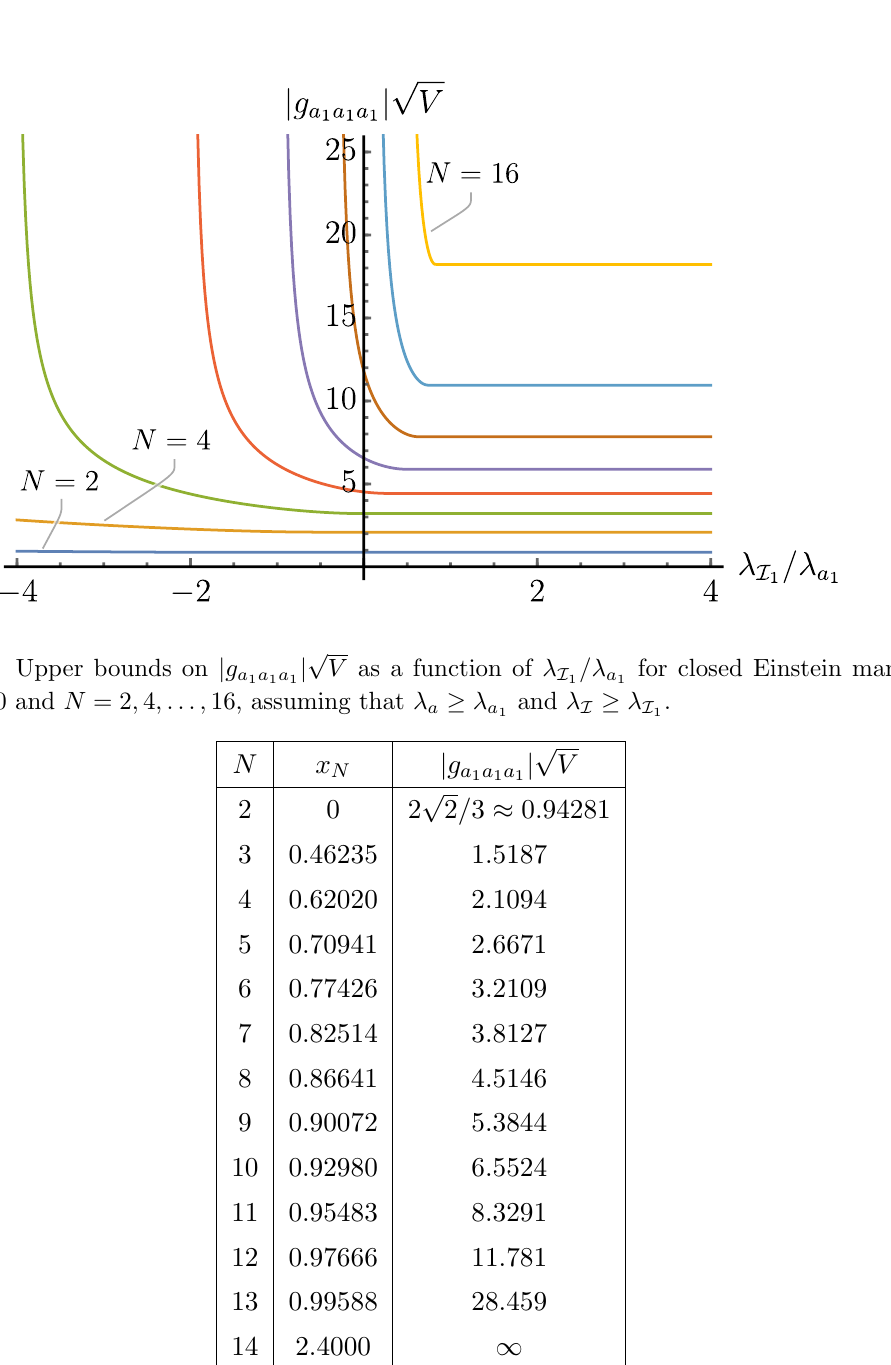
Table 2 . Upper bounds on the size of the cubic self-coupling j g a manifolds with R (cid:21) 0 and (cid:21) I (cid:21) 0 as (cid:21) a smallest value of (cid:21) a